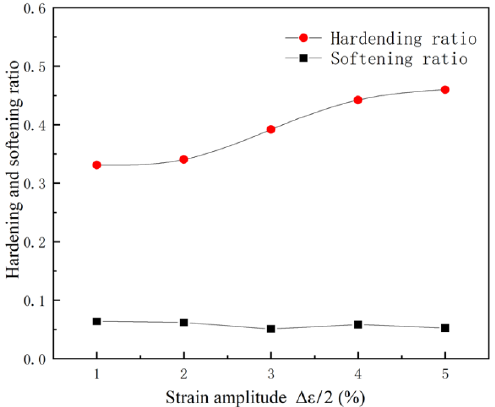
Figure 6. Cyclic hardening and softening ration under different strain amplitudes.